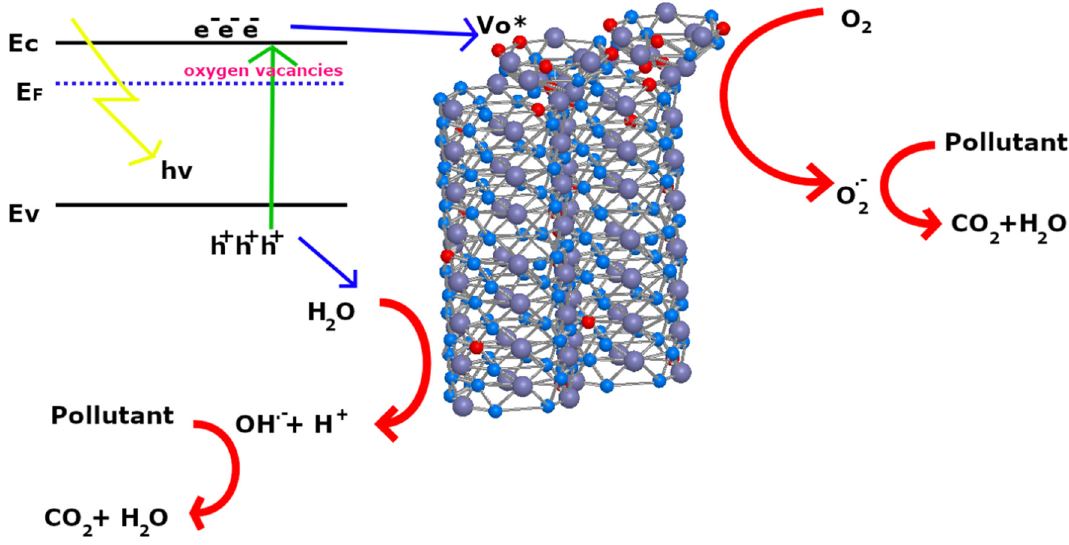
Figure 8. Schematic diagram of photocatalytic process in TiO 2 nanomaterials. Here titanium, oxygen and single-ionized oxygen vacancies are represented by gray circles, blue circles and red circles, respectively.